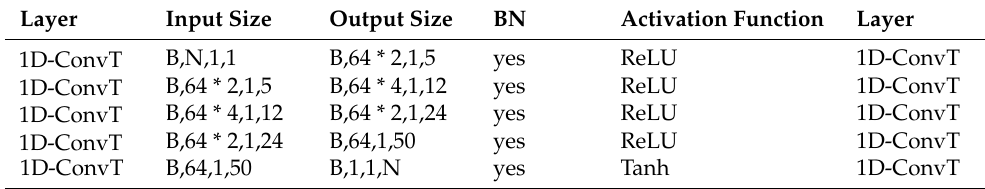
Figure 3. The structure of the MS-PGAN model. Table 1. The MS-PGAN’s generator network structure parameters.